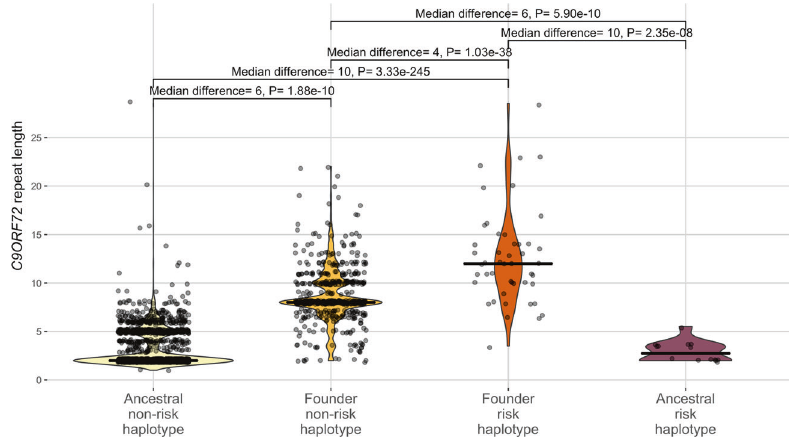
Fig. 3 C9ORF72 repeat length (excluding haplotypes with >30 repeats) in C9ORF72 haplotypes, including ancestral non-risk haplotypes, ancestral risk haplotypes, founder non-risk haplotypes and founder risk haplotypes. The founder haplotype is de fi ned by the presence of rs3849942-C (tags ancestral allele) or rs3849942-T (tags founder allele). Risk status is de fi ned by the presence of at least one risk allele, including rs117204439-C or rs147211831-A. Abbreviation(s) C9ORF72 : chromosome 9 open reading frame